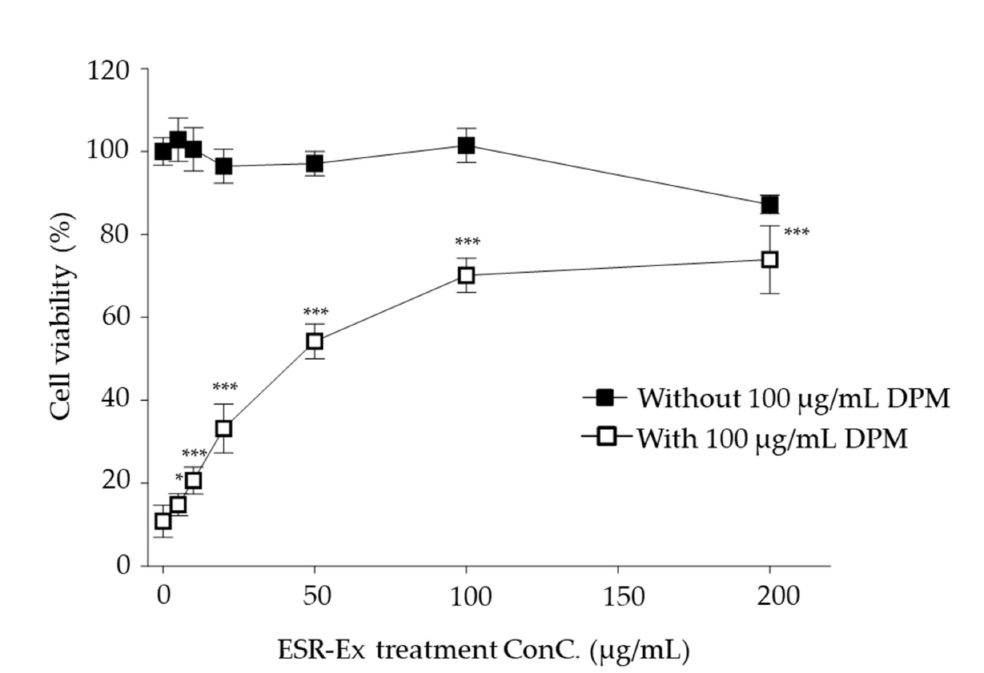
Figure 1. ESR-Ex suppresses decreases in cell viability in KC treated with DPM. KCs were incu- bated with indicated concentration of ESR-Ex or vehicle for 30 min, and then further cultured with 100 µ g/mL of DPM for 24 h. Cell viability was measured by water-soluble tetrazolium salt cell quantification method. All values are mean ± SD ( n = 3). Statistically significant differences of ESR + DPM (open square), *** p < 0.001 or * p < 0.05 vs. vehicle control without DPM. See details in Materials and Methods